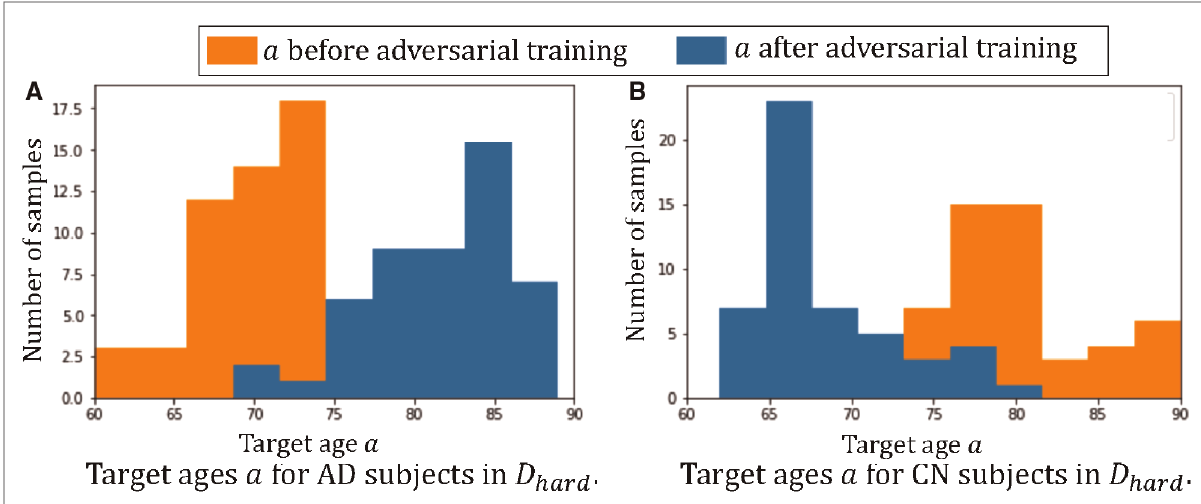
FIGURE 5 Histograms of target ages a before and after adversarial training: ( A ) the histogram of a for the 50 AD subjects in D hard ; ( B ) the histogram of a for the 50 CN subjects in D hard . Here we show histograms of a before (in orange) and after (in blue) the adversarial